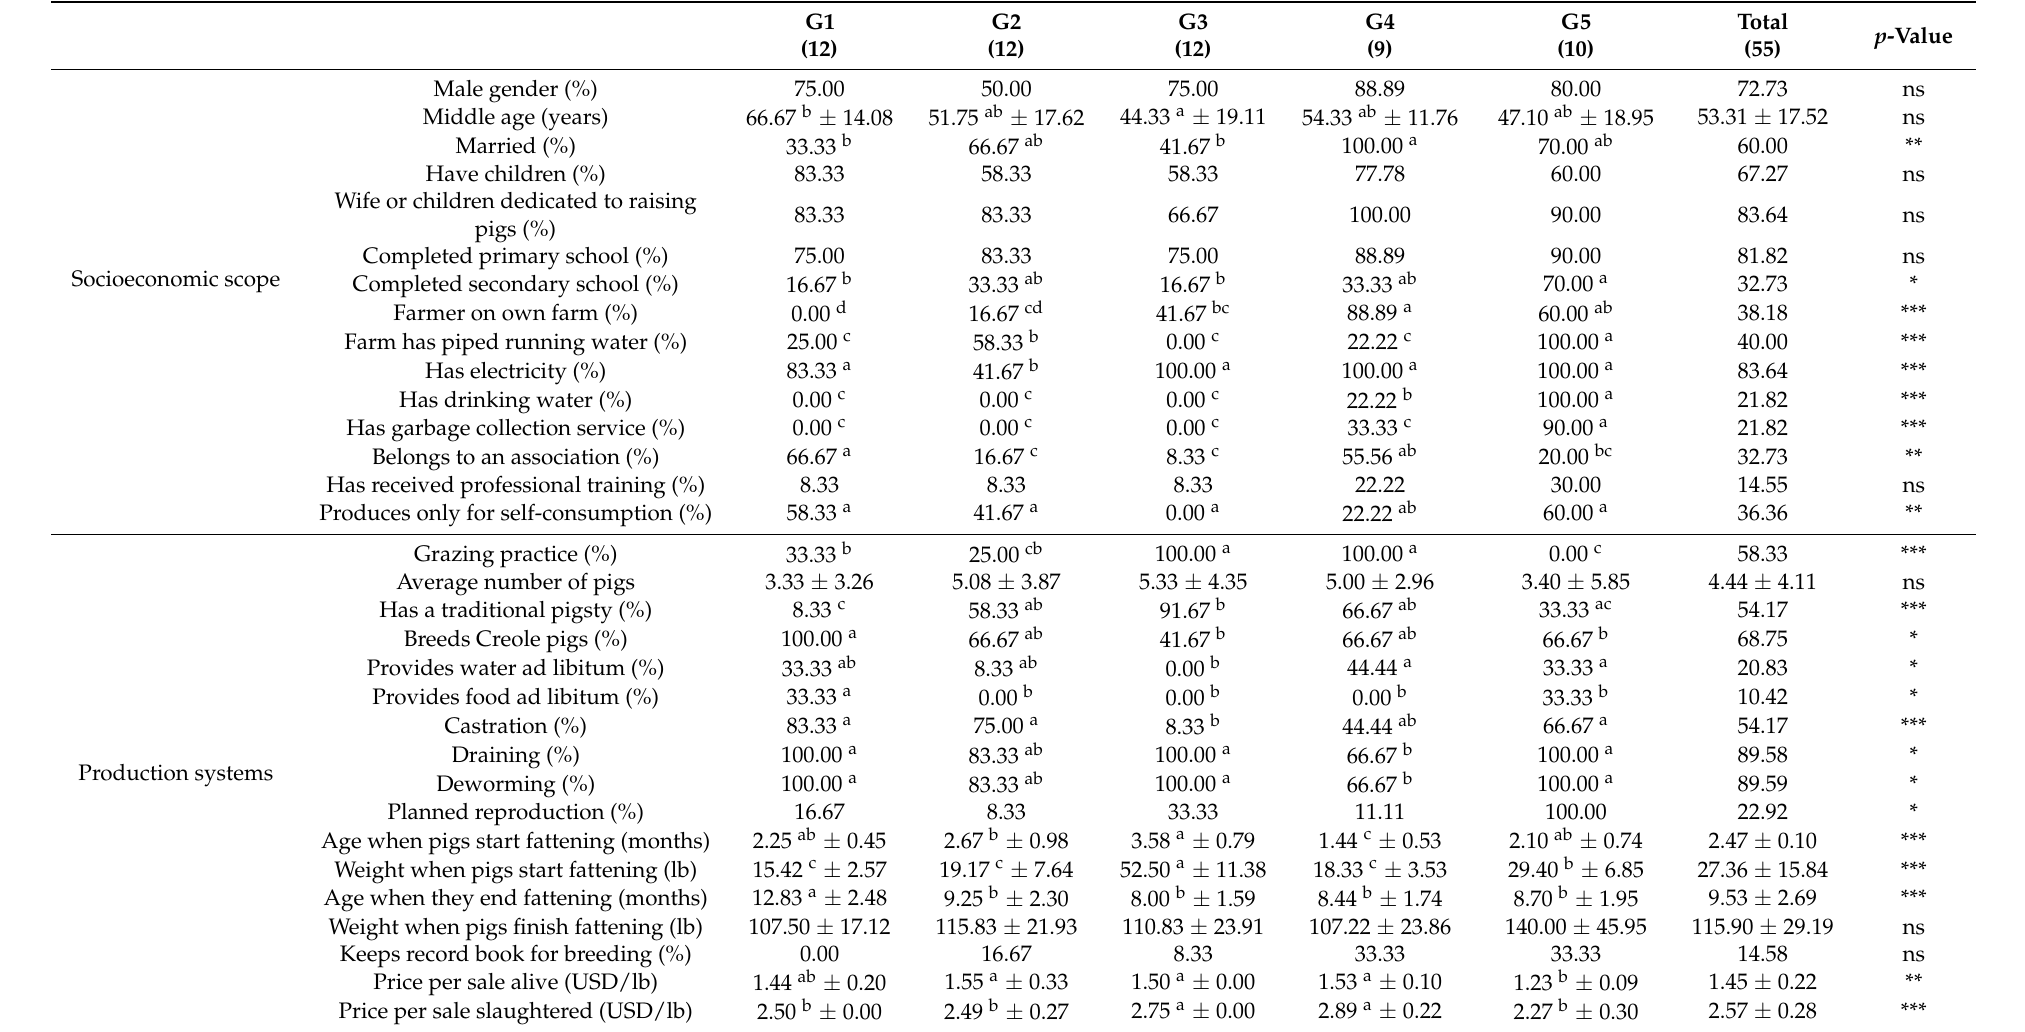
Table 7. Characteristics and comparative analysis of the five groups of small producers of backyard pigs in Jipijapa. In brackets is the number of